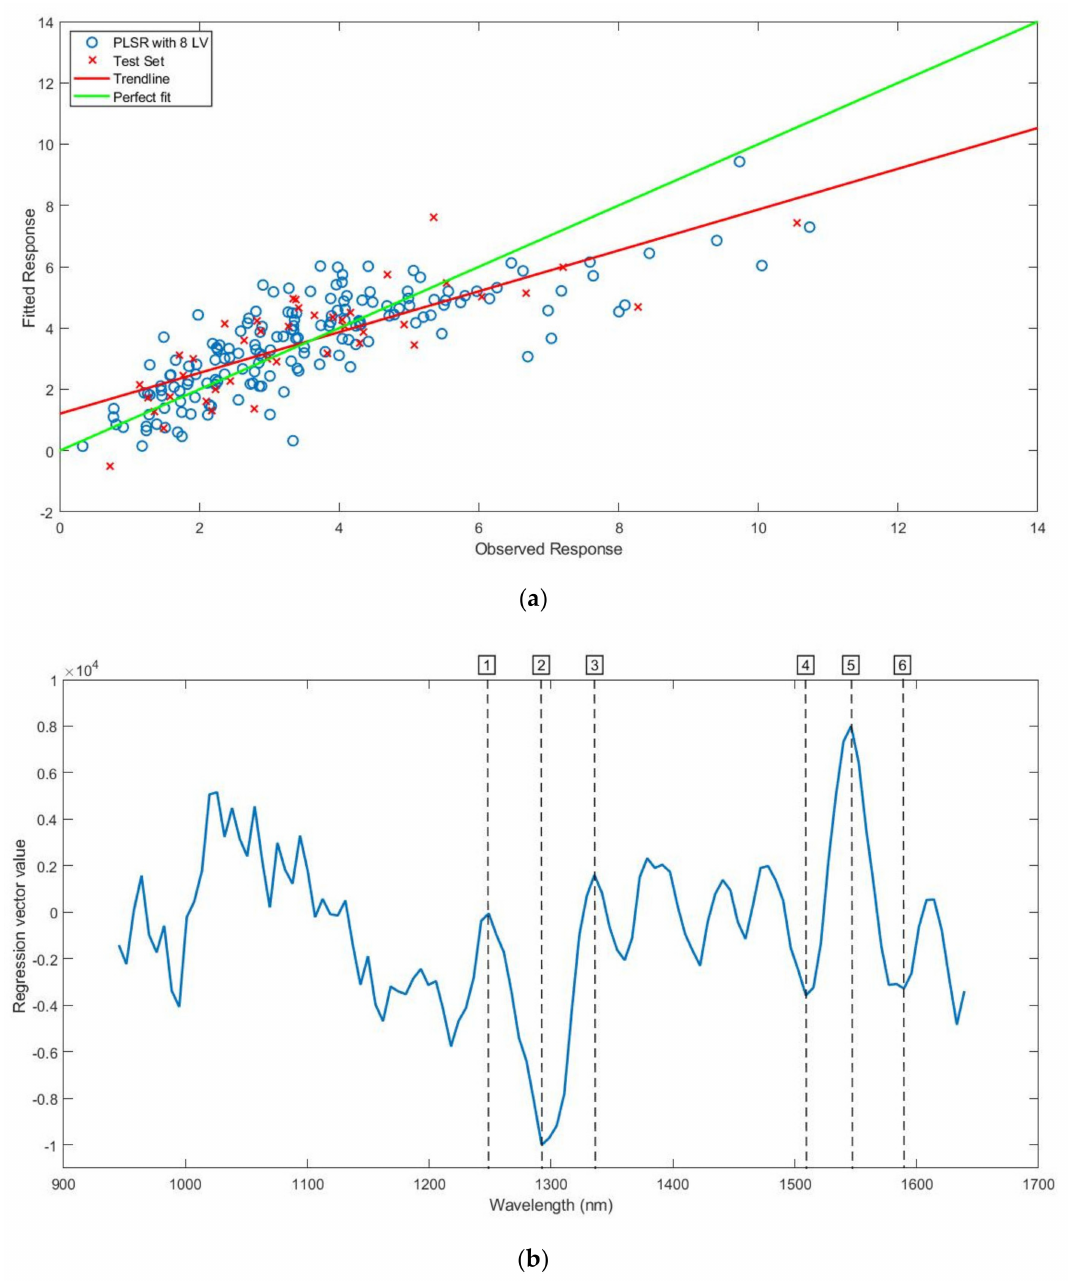
Figure 4. ( a ) Partial least squares regression plot for the prediction of AC ad on WD gr . Spectra were pre-processed by second order derivation using the Savitzky-Golay algorithm with 13 smoothing points and 8 latent variables; ( b ) Corresponding regression vector plot using vertical lines and numbers to highlight the most important